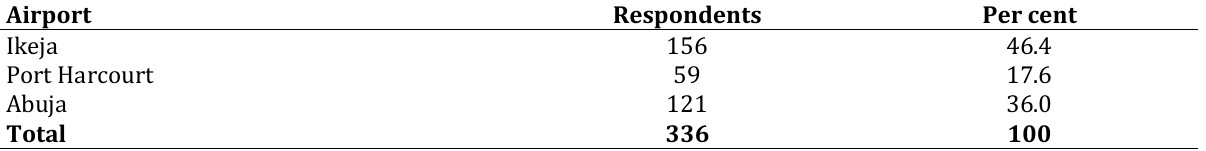
Table 3: Distribution of respondents by